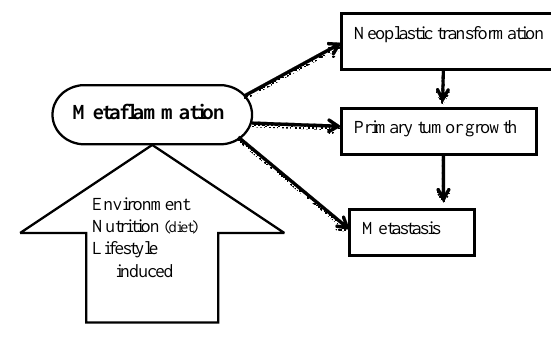
Figure-1. Metaflammation initiates and impacts all major stages of tumor progression, from neoplastic transformation to widespread